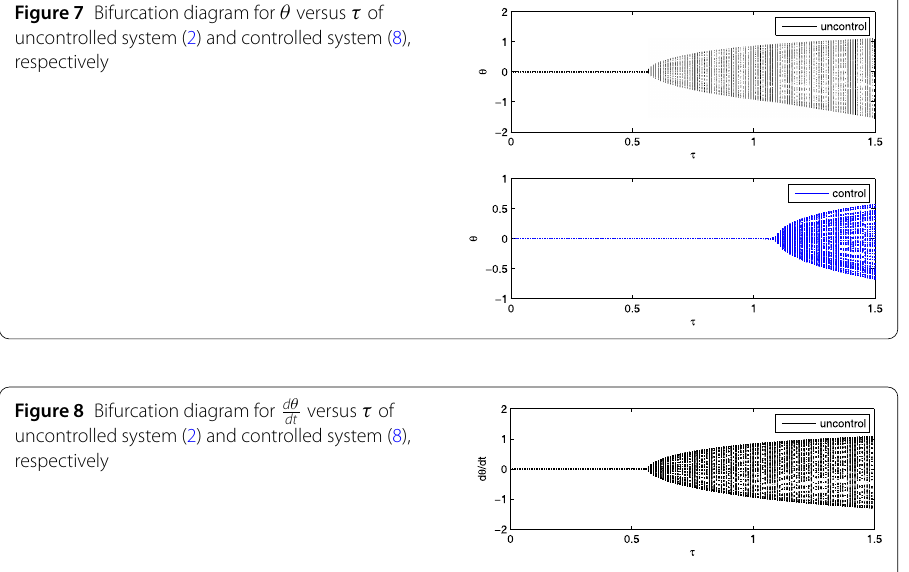
Figure 8 Bifurcation diagram for d θ uncontrolled system (2) and controlled system (8), respectively